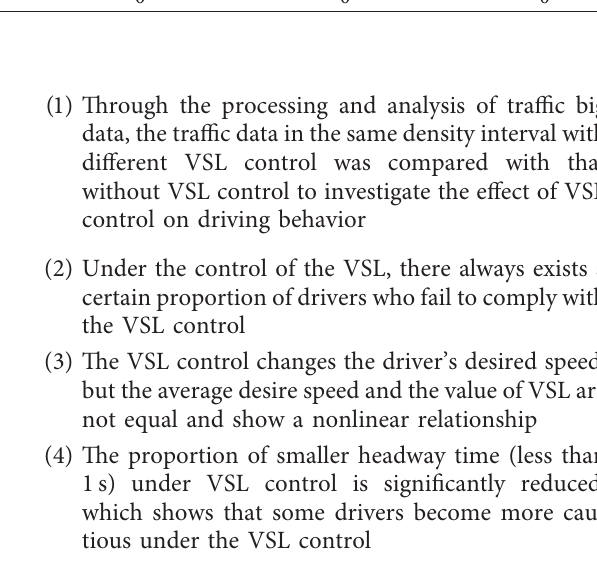
Figure 5: ASD of two adjacent vehicles in different speed limit values and different density